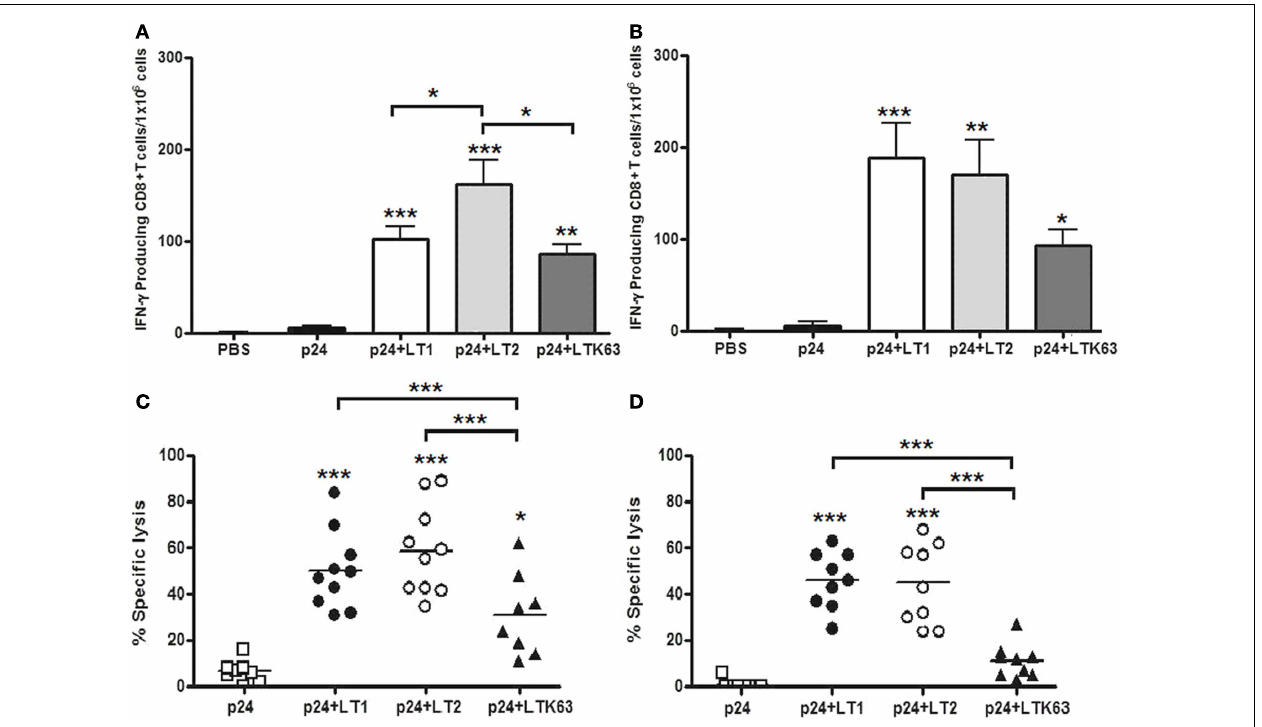
FIGURE 5 | CD8 + T cell adjuvant effects of LT derivatives administered via i.d. and s.c. routes . (A,B) IFN- γ ELISPOT assay carried out with spleen cells of mice immunized with four doses of p24 adjuvanted with LT1, LT2, or LTK63 or p24 non-adjuvanted. Spleen cells were harvested from animals immunized via i.d. (A) or s.c. (B) routes 2weeks after the last vaccine dose. Cells were stimulated with a synthetic peptide encompassing the p24 immunodominant MHC-I-restricted CD8 + T cell epitope for detection of IFN- γ -secreting cells. Results are expressed as means ± SD ( n = 4–5 per immunization group). Experiments were performed independently three times. (C,D) In vivo CTL responses in